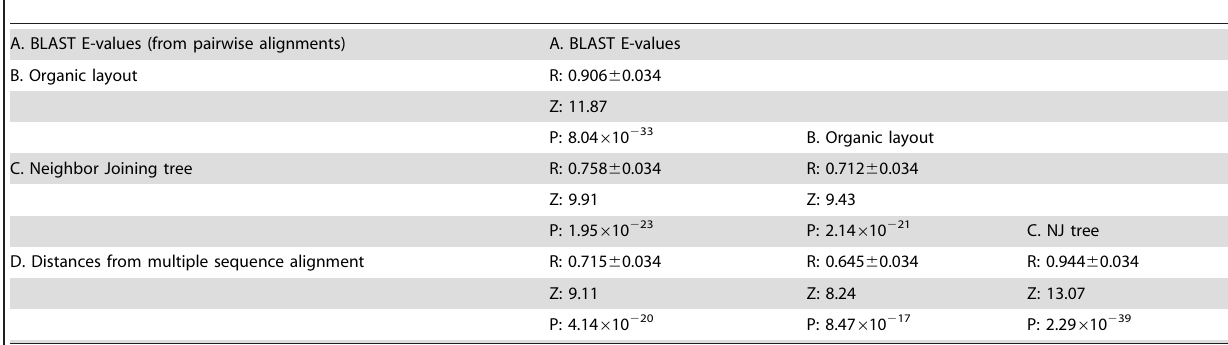
Table 1. Comparison of mathematically ideal and displayed pairwise network distances between 42 human amine-binding